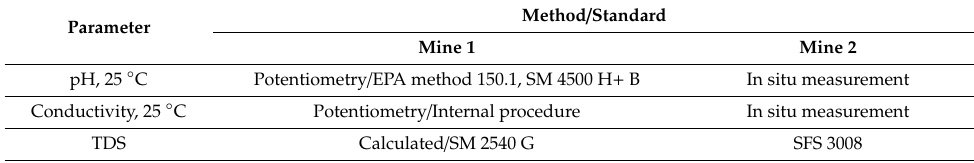
Table A1. Methods and standards used by the contracted laboratories for water